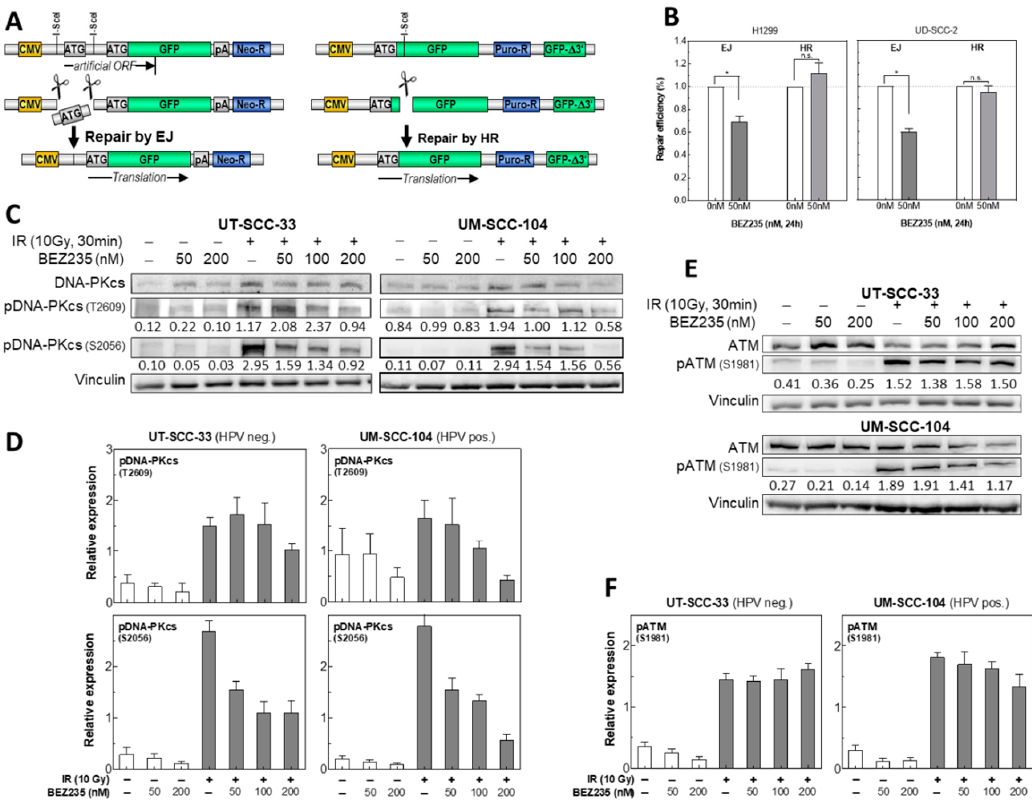
Figure 4. E ff ect of BEZ235 on DSB repair pathways. ( A ) Double-Strand Break (DSB) repair constructs for end-joining (EJ) and for homologous recombination (HR). ( B ) E ff ect of BEZ235 on non-homologous end joining (NHEJ) and HR. H1299 and UD-SCC-2 cells with stably integrated repair plasmids were incubated with BEZ235 (50 nM) for 24 h before repair activity was determined via flow cytometry. Values are normalized to the activity measured for untreated cells. Significant di ff erences between conditions are shown with asterisks (p-value < 0.05). ( C , D ) E ff ect of BEZ235 on the radiation-induced activation of DNA-PKcs. Cells were incubated with BEZ235 (0–200 nM) for 2 h before irradiated with 10 Gy. Protein extracts of UT-SCC-33 and UM-SCC-104 cells were prepared 30 min after irradiation and level of DNA-PKcs, and pDNA-PKcs at T2609, as well as S2056 were measured using Western blotting. ( E , F ) E ff ect of BEZ235 on the radiation-induced activation of ATM. Cells were incubated with BEZ235 (0–200 nM) for 2 h before irradiation with 10 Gy. Protein extracts of UT-SCC-33 and UM-SCC-104 cells were prepared 30 min after irradiation and the level of ATM and pATM (S1981) was measured using Western blotting.